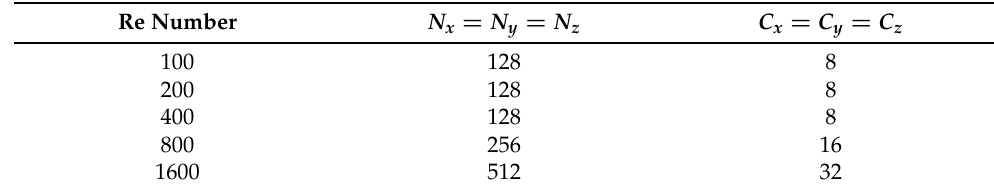
Table 3. Number of spatial divisions N x = N y = N z and number of MPI subdomains (CPU cores) C x = C y = C z along each coordinate direction of the grids used for the solution of the three-dimensional Taylor-Green vortex with different Reynolds numbers.